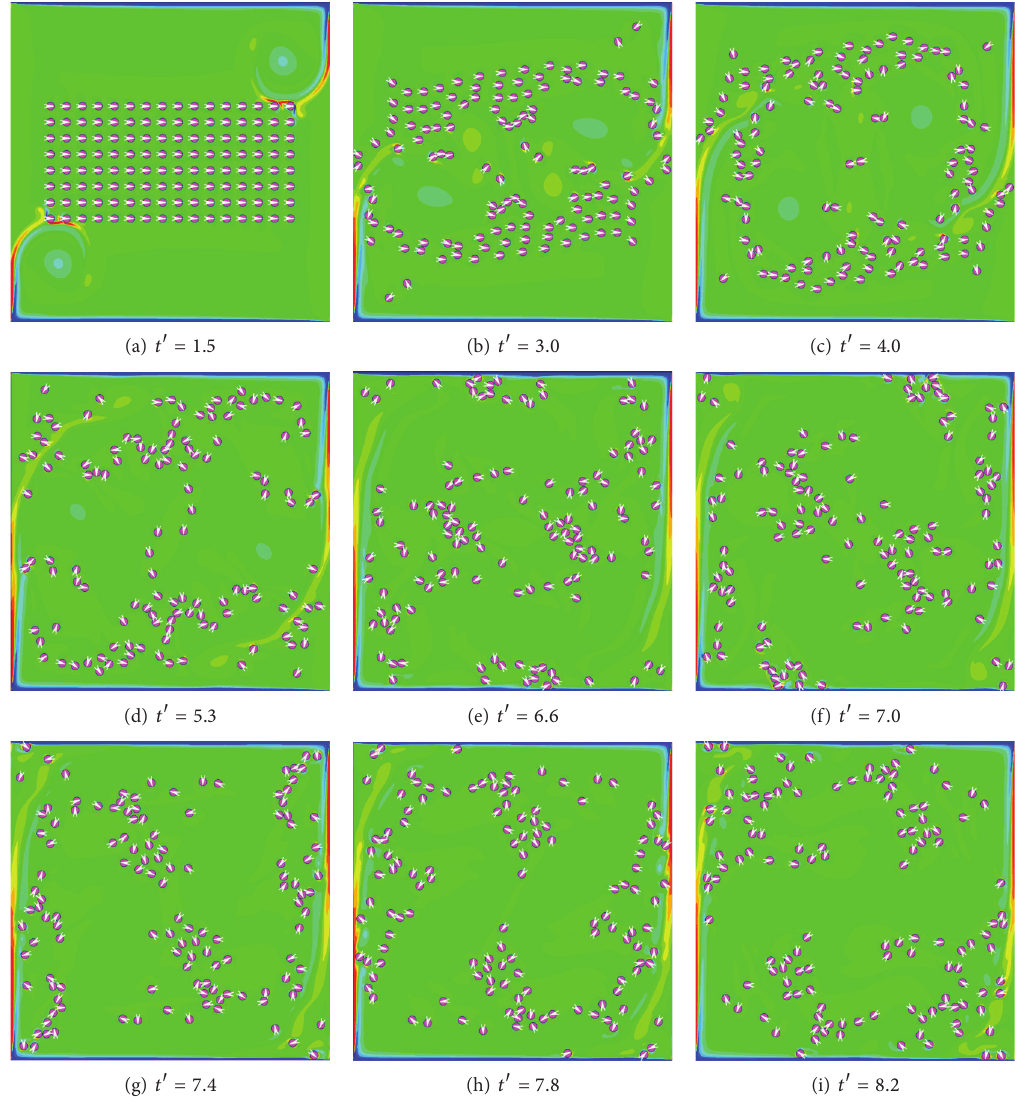
Figure 4: Vorticity contours when 𝑈 0 = 0.2